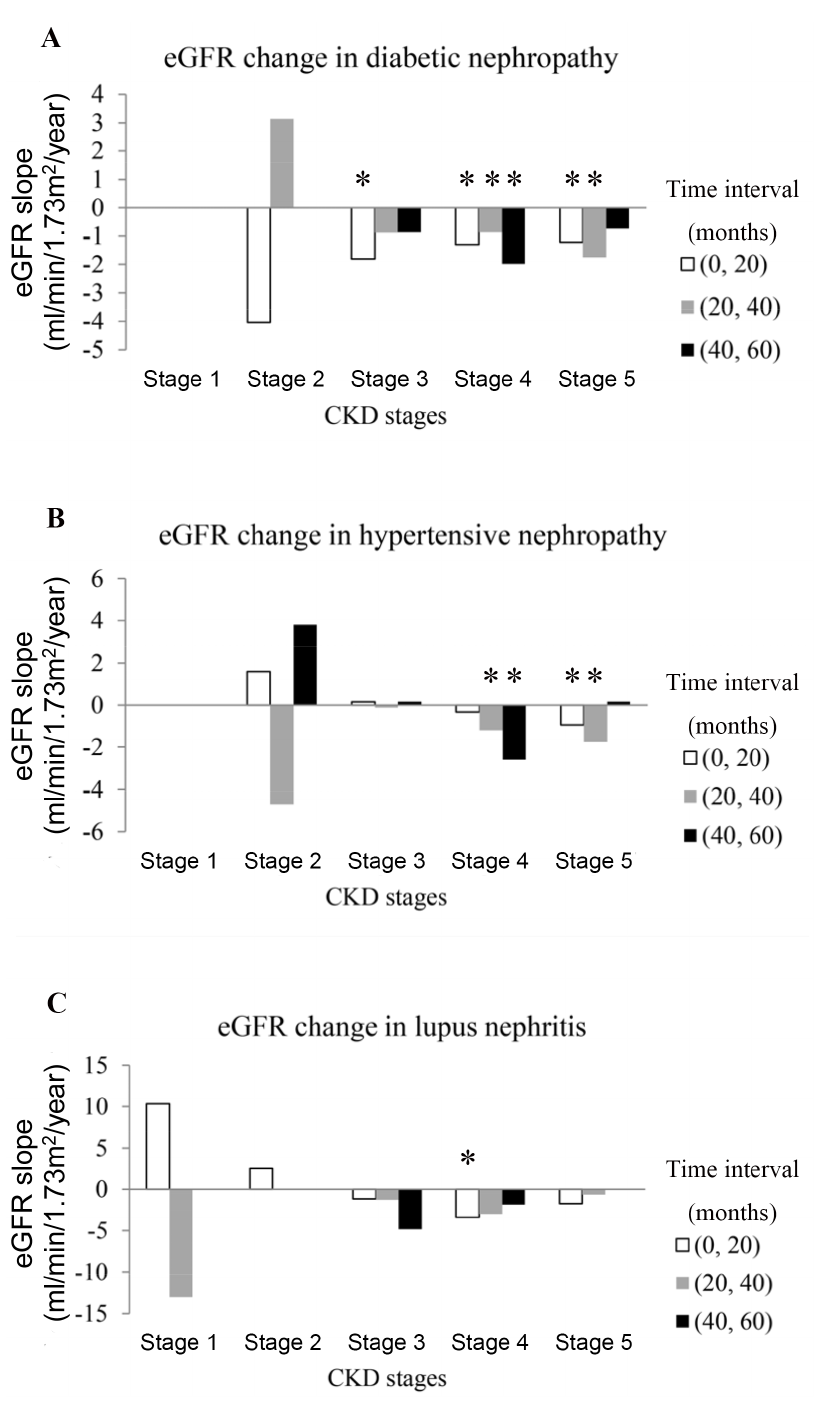
Figure 2. eGFR decline in systemic disease-related nephropathy (Significant codes: *, , 0.05 means the eGFR decline is a significant value during this time interval under lineal regression model).